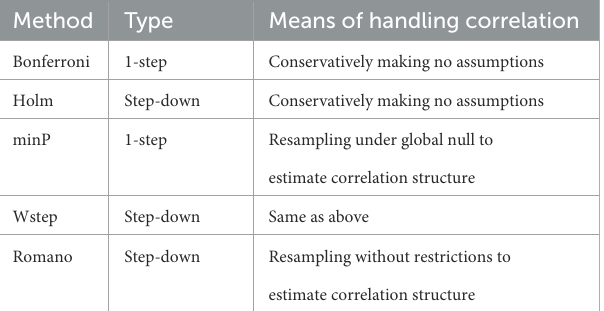
TABLE 1 Selected existing methods for strong FWER control with correlated hypothesis